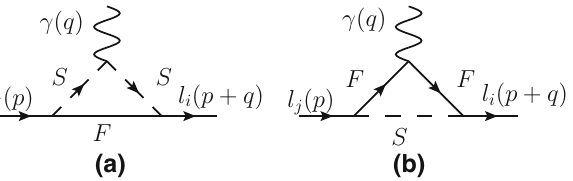
Fig. 1 The one-loop diagrams affect ( g − 2 ) μ in the BLMSSM and